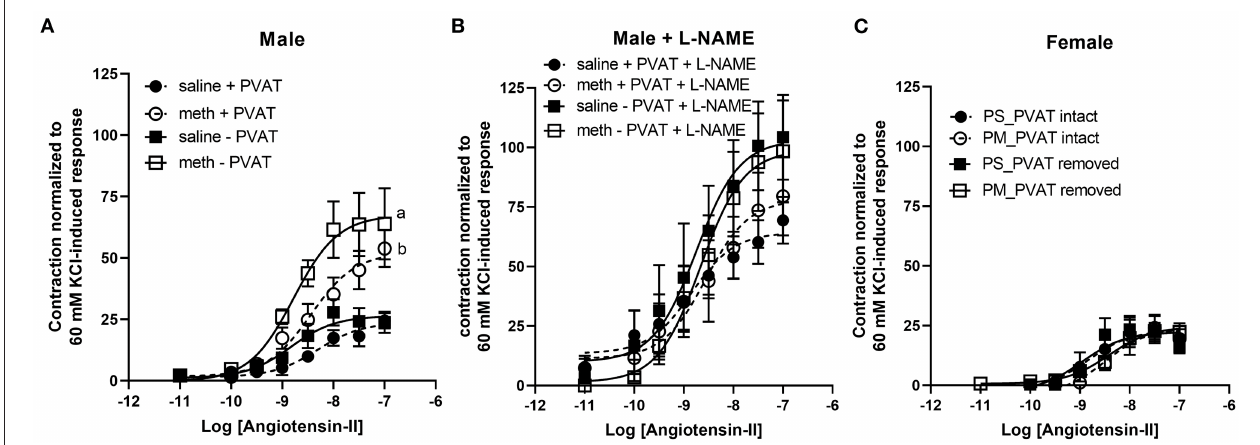
FIGURE 3 | Prenatal methamphetamine sex-dependently potentiates angiotensin II-induced contraction of isolated aortas. The magnitude of angiotensin II-induced contractile responses were significantly [F = 15 (1, 25), p < 0.001] potentiated in aortas from adult male rats that had been prenatally treated with methamphetamine compared to aortas from males that had been prenatally treated with saline regardless of whether PVAT was present (A) . Prenatal exposure to methamphetamine had no impact on angiotensin II-induced contractile responses in the presence of 100 µ M L-NAME. The magnitude of angiotensin II-induced contraction was significantly [F = 4 (1, 20), p = 0.05] increased by PVAT in the presence of L-NAME, but post-hoc analysis did not indicate differences between specific groups (B) . Angiotensin II-induced-responses in female aortas were unaffected by prenatal methamphetamine (C) . a indicates a significant difference ( P < 0.05) compared to aortas from saline treated rats in the absence of PVAT (– PVAT), and b indicates a significant difference ( p < 0.05) compared to aortas from saline treated rats with the PVAT intact ( + PVAT). Data represent the mean ± SEM of 6–8 separate animals.